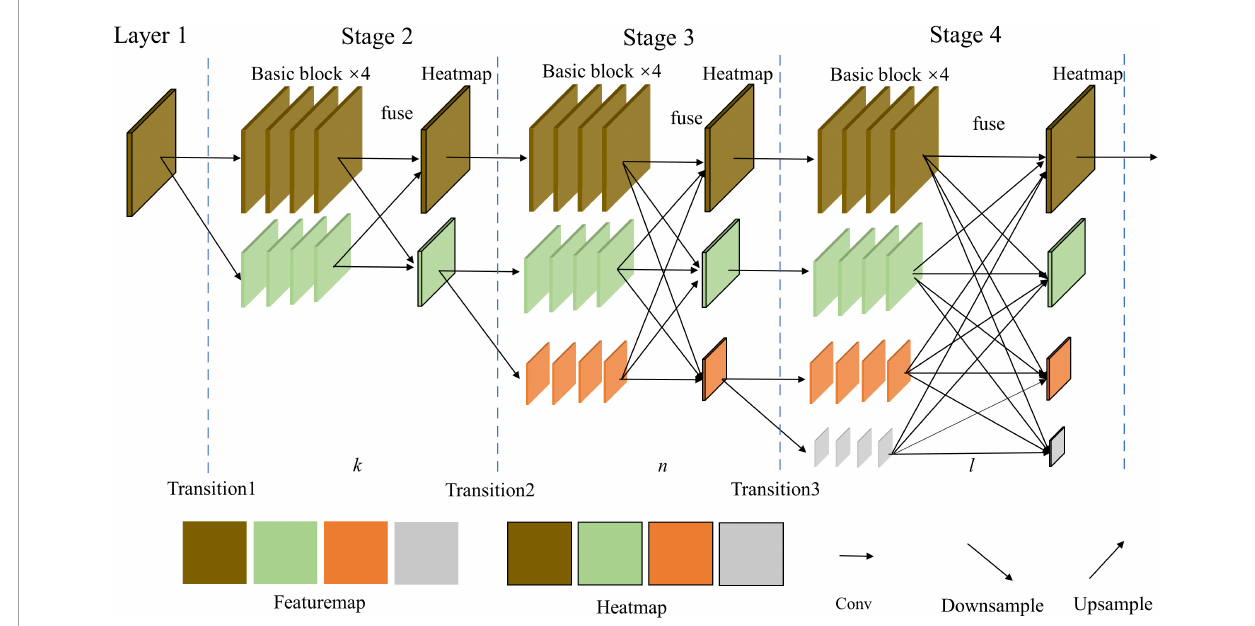
FIGURE3 HR model with an inverse pyramid parallel structure and information exchange fuse.